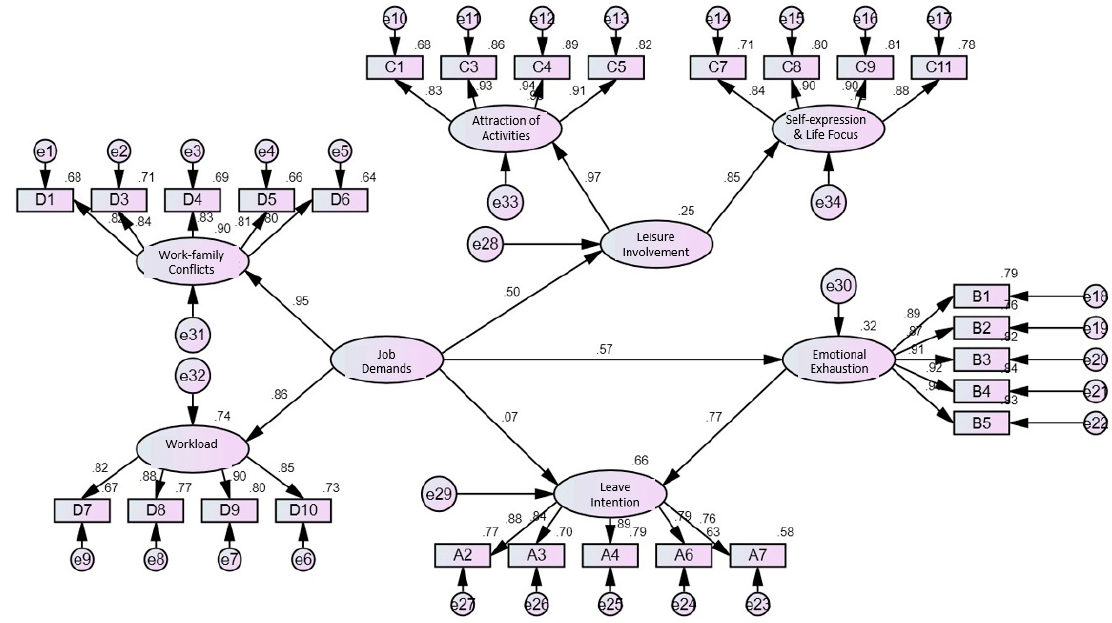
Figure 2. Relation diagram of healthcare providers’ job demands, leisure involvement, emotional exhaustion, and leave intention under the COVID-19 pandemic.